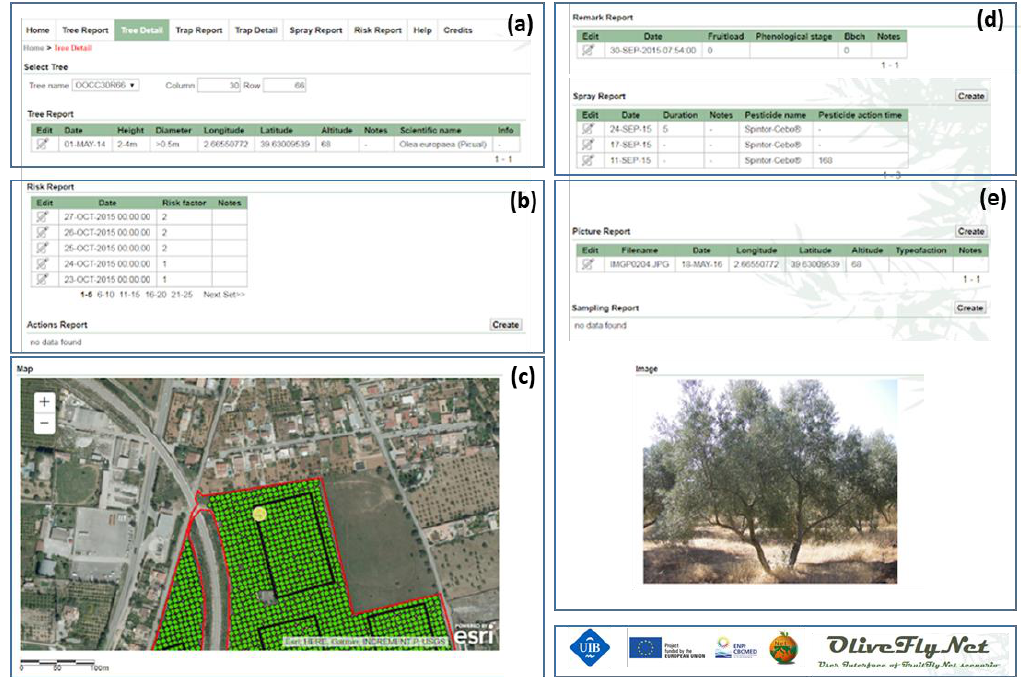
Figure 6. Output of the OliveFlyNet applications interface showing details about information stored in the UIB geodatabase: ( a ) Tree location and identification, ( b ) Risk report according to DSS, ( c ) Tree location map, ( d ) Spray report as conducted in the tree, and ( e ) Tree picture.